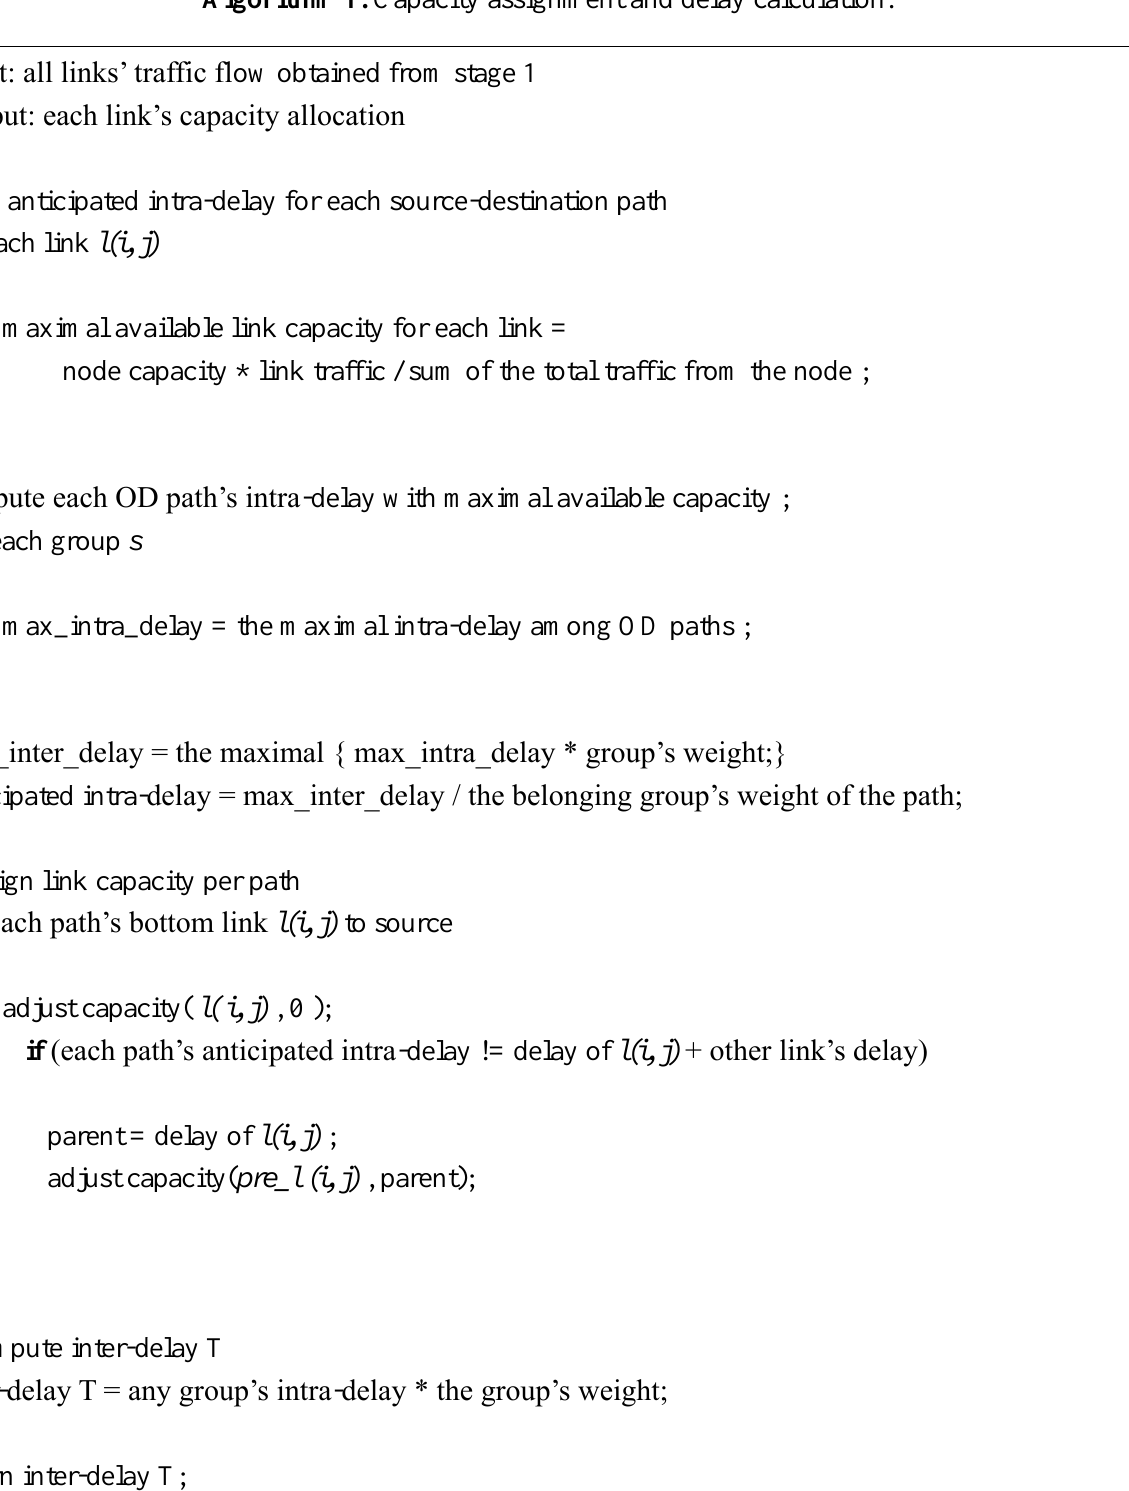
Algorithm 1. Capacity assignment and delay